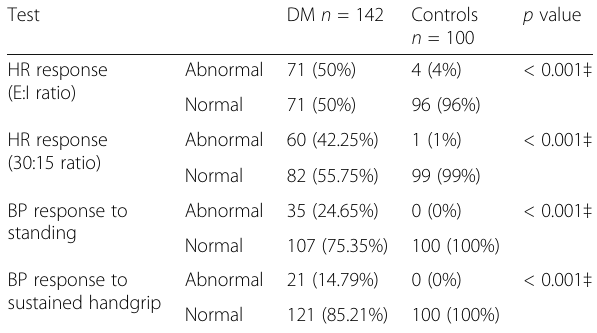
Table 2 Cardiovascular autonomic tests of the study population Test